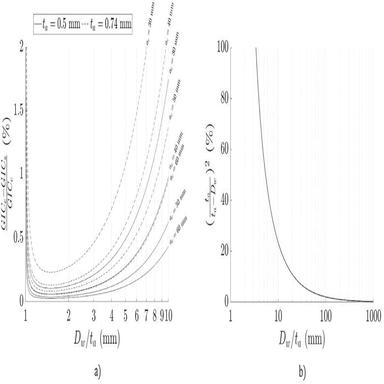
Relative error in the measurement of fracture toughness: (a) between the exact and simplified formulations in the function of the ratio Dw/ta (in logarithmic scale) for different crack lengths and adhesive thicknesses, and (b) through the simplified formulation in the function of the ratio Dw/ta taking into account bondline thickness (GICs(ta)) or neglecting it (GICs ( 0 ta = )).